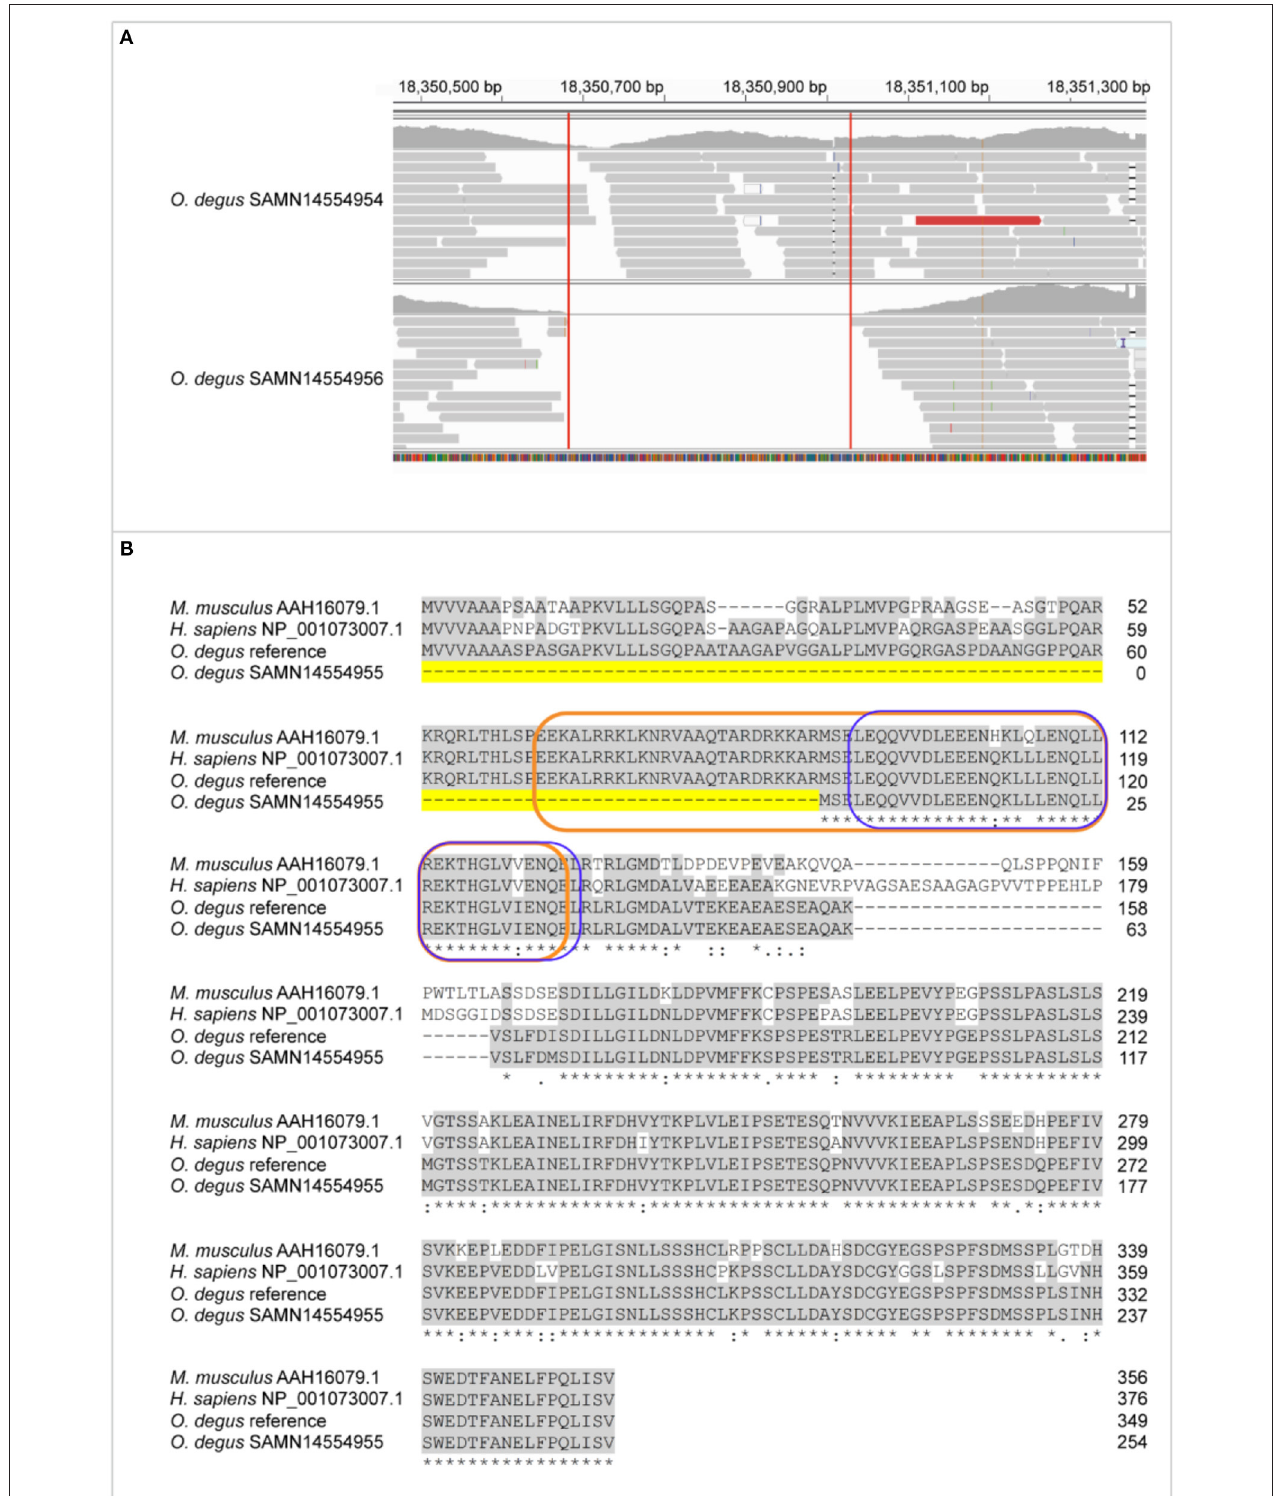
FIGURE 2 | Exon 1 is lost in Xbp1 due to 27bp deletion of bZIP N-terminal. (A) Genome mapping of degu SAMN14554954, an animal that had the complete XBP1 sequence and degu SAMN14554956 that carried the exon 1 deletion compared to the degu reference genome GCF000260255 in the XBP1 coding sequence. (B) Alignment of amino acid sequence between M. musculus, H. sapiens XBP1s isoform and degu SAMN14554954 and SAMN14554956. Conserved amino acid sequences among all the aligned organism sequences are greyhighlighted. Dashed line highlighted in yellow represents the amino acid deletion of XBP1 in degu SAMN14554956. The bZIP domain is outlined orange and the leucine zipper outlined in blue.